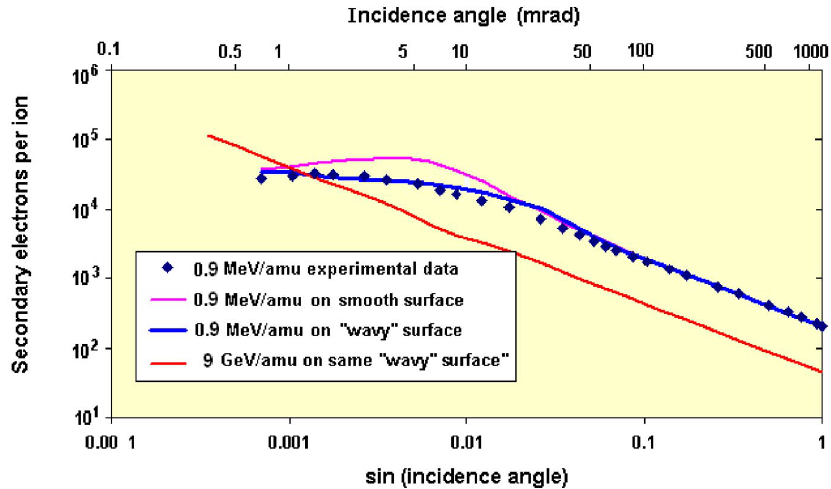
FIG. 4. (Color) 182 MeVgold on stainless steel secondary electron data and various results from simulations including one curve for 9 GeV = amu (see text).